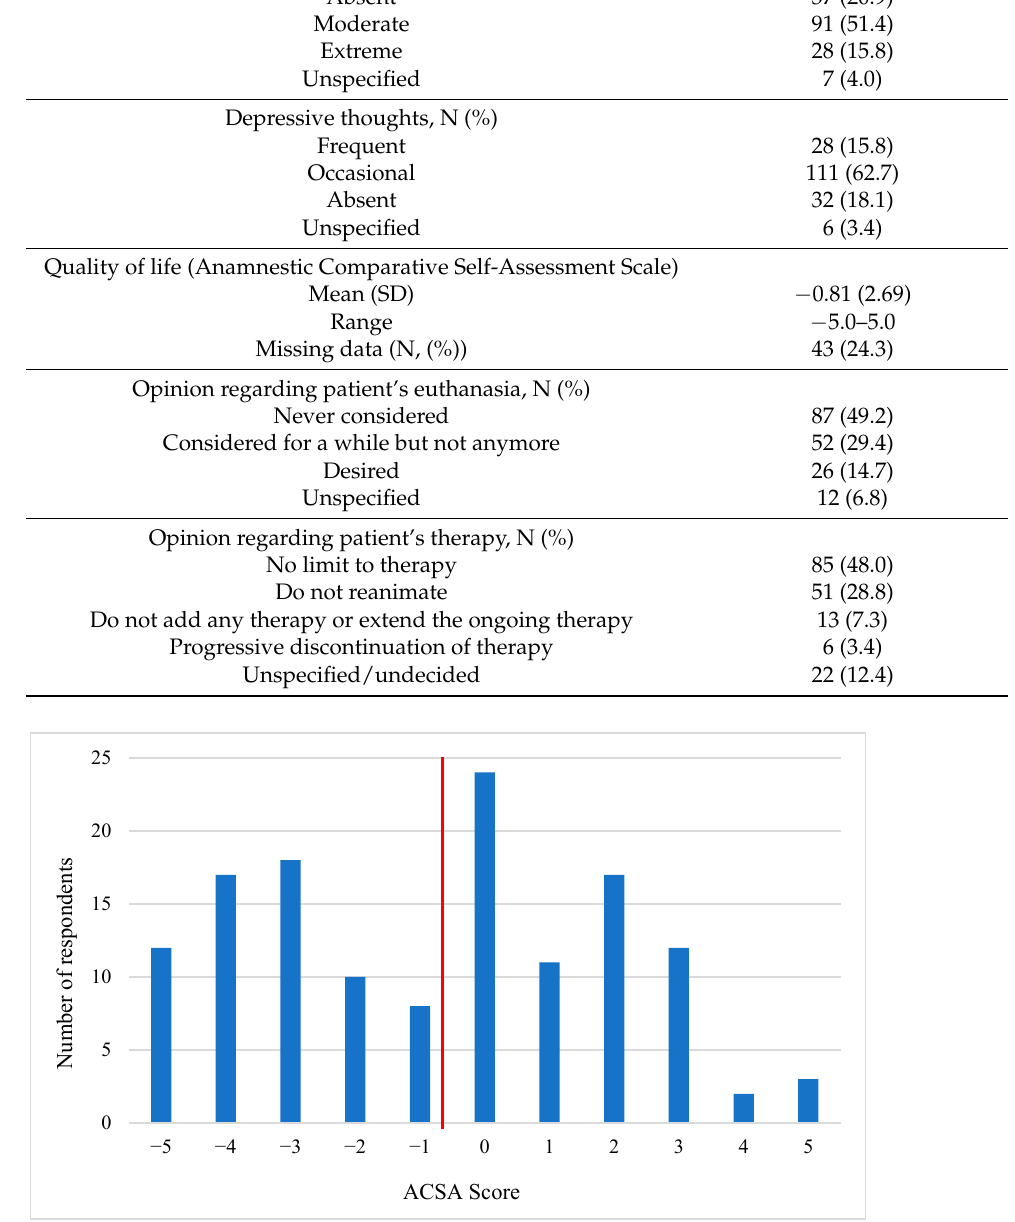
Figure 3. Repartition of the QoL score (ACSA). The red line corresponds to the mean QoL of the sample ( − 0.81).